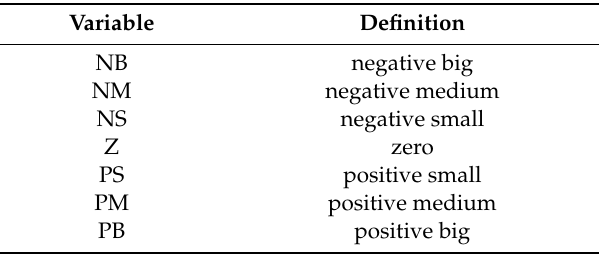
Table 2. Linguistic variables for error and error